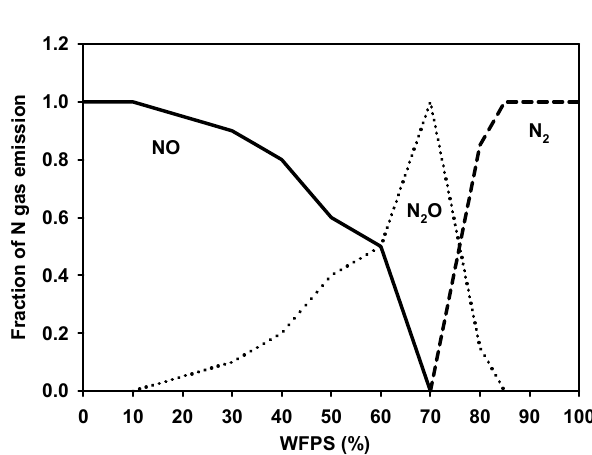
Fig. 3. Model of N gas production as a function of WFPS (water- Fig. 3 975 filled pore space, %). The solid line represents NO; short dashed line represents N 2 O fraction; and long dashed line represents N 2